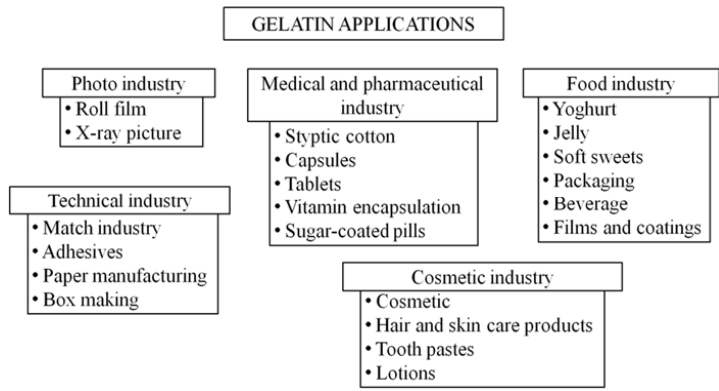
Figure 2. Some final applications and uses of gelatin.